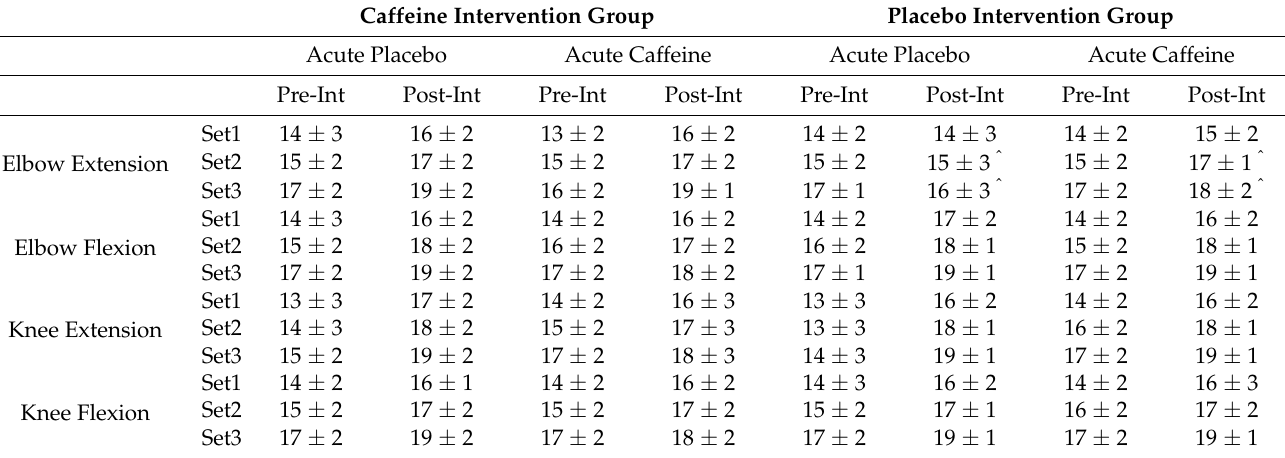
Table 4. Acute effect of caffeine treatment (3 mg · kg − 1 ) pre and post-7-week resistance training on RPE following re- peated